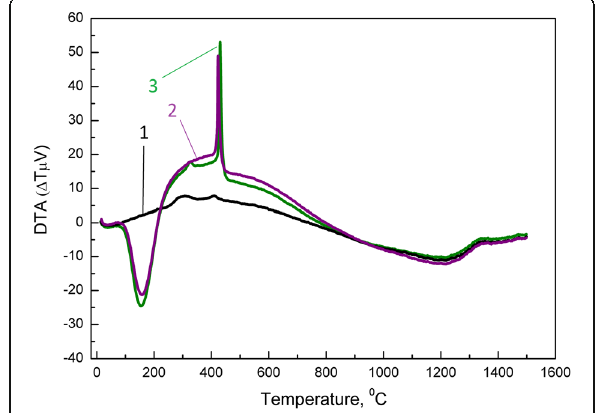
Fig. 3 DTA curves of samples: 1- PMM8-3Y-TZP-0.2 wt% SiO 2 (- nanopowders were calcined at 1000 °C for 2 h); 2 - 3Y-TZP-0.2 wt% SiO2 (hydroxide); 3- 3Y-TZP